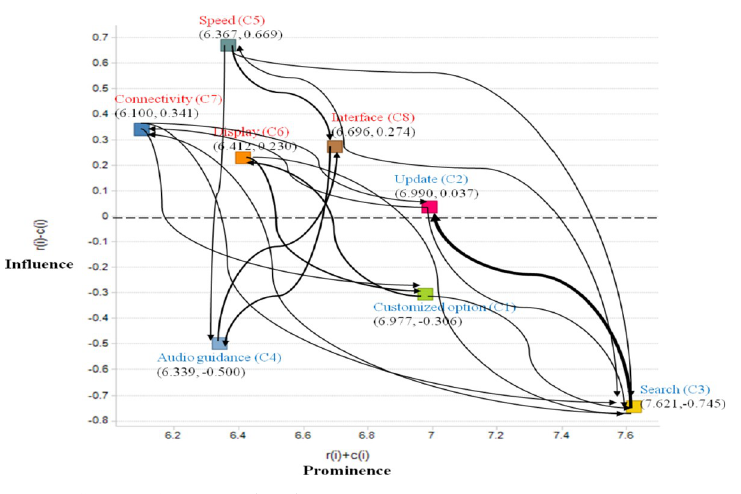
Fig 4. Influence relation map